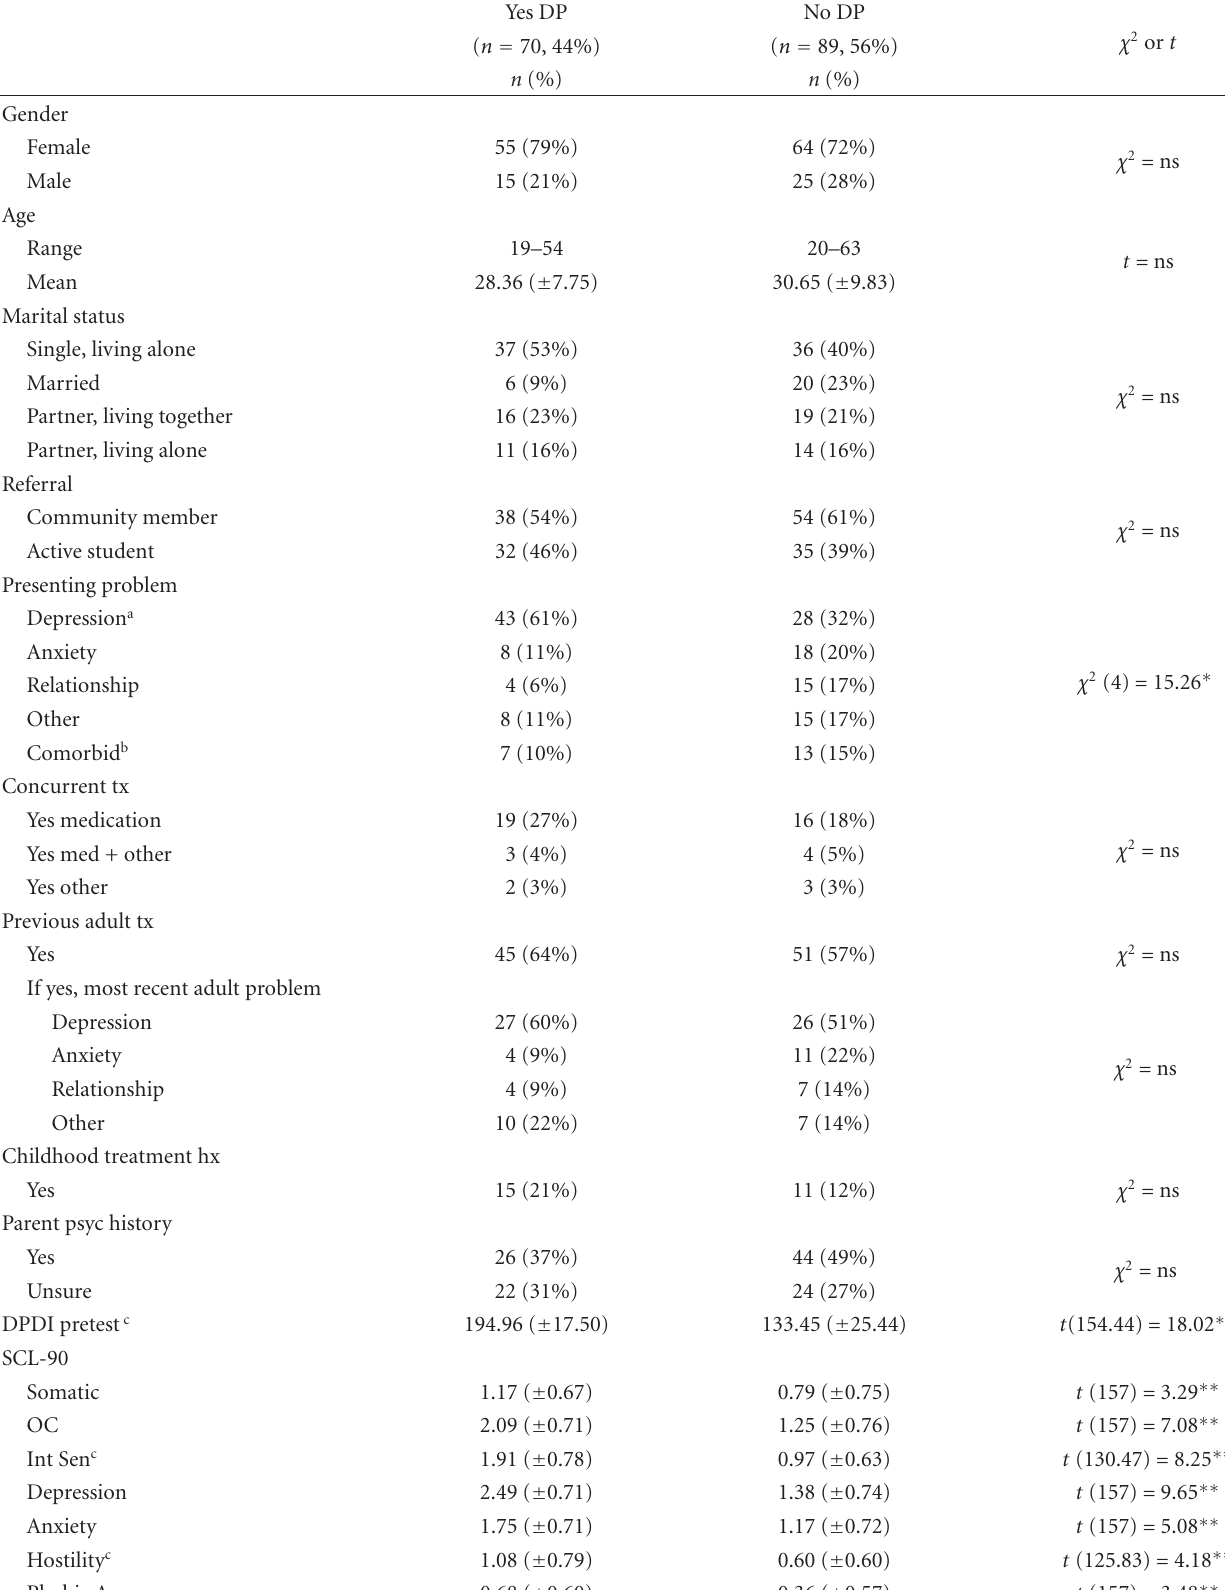
Table 1: Demographics and clinical characteristics for full sample ( N = 159) split by